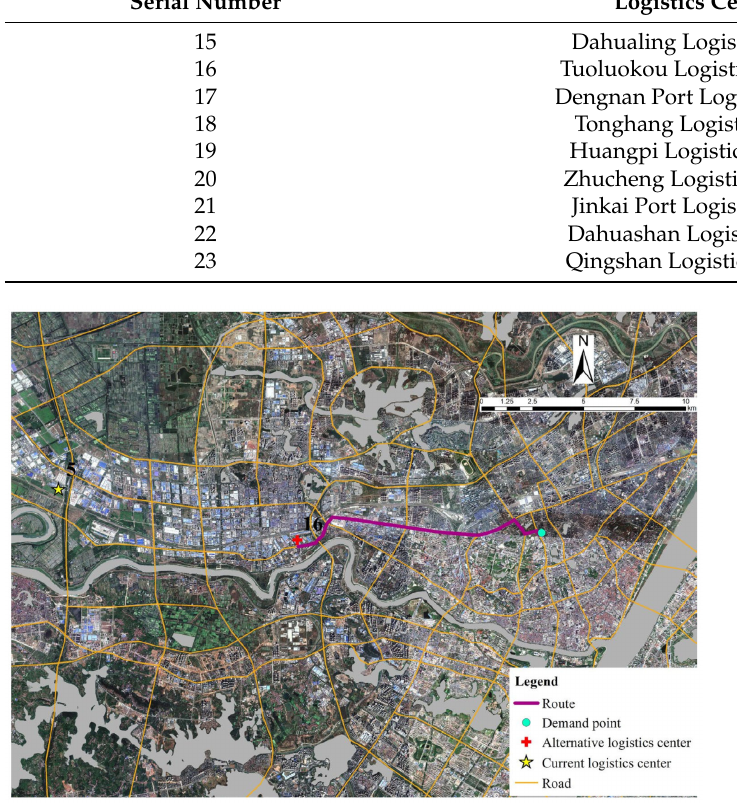
Figure 8. The distribution of the logistics demand points in